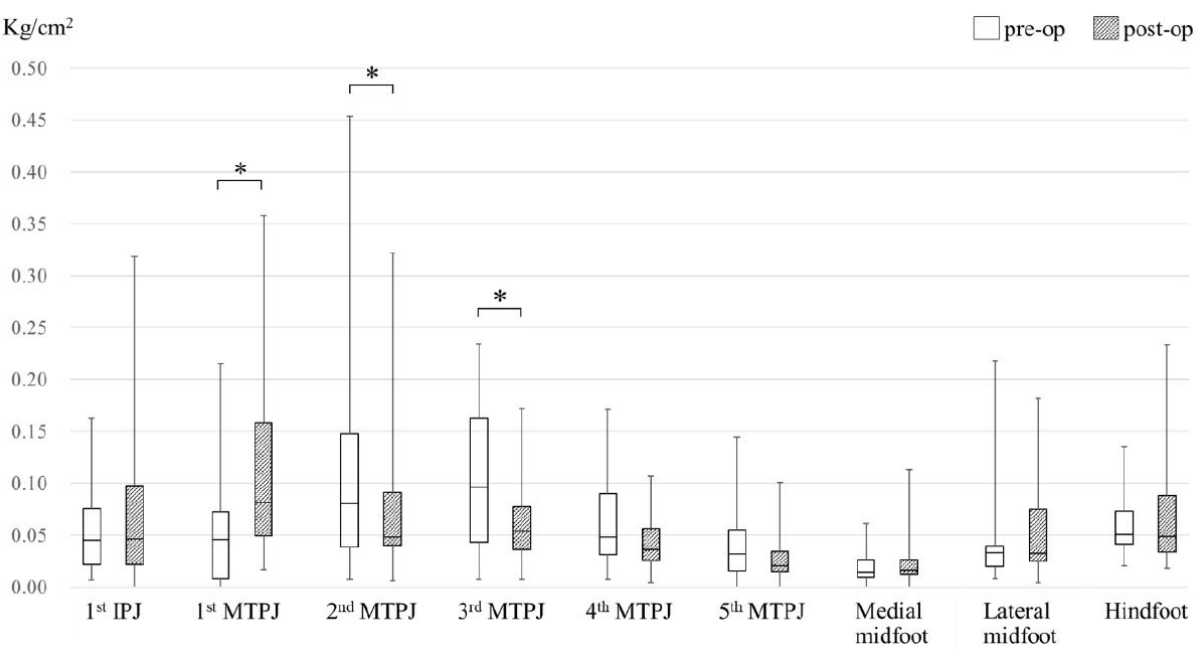
Figure 2. Preoperative and postoperative median peak pressure value. IPJ = interphalangeal joint; MTPJ = metatar- sophalangeal joint. A significant difference between preoperative and postoperative values is indicated by an asterisk. *: p < 0.05.